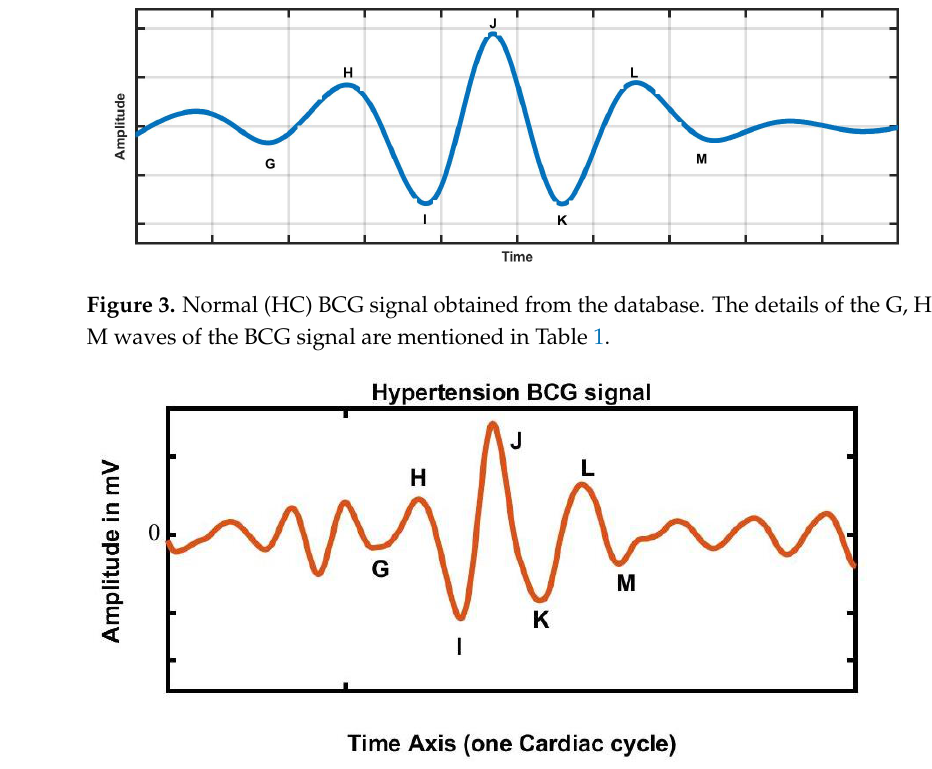
Figure 4. HPT BCG (abnormal) signal acquired from the database. The HPT BCG signals have fast variations in the time axis and abrupt rises and falls in amplitude compared with the normal BCG